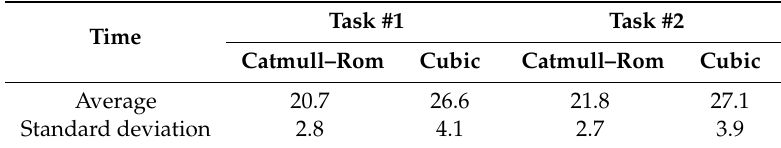
Table 2. Computation time for the trajectory planning in ms.